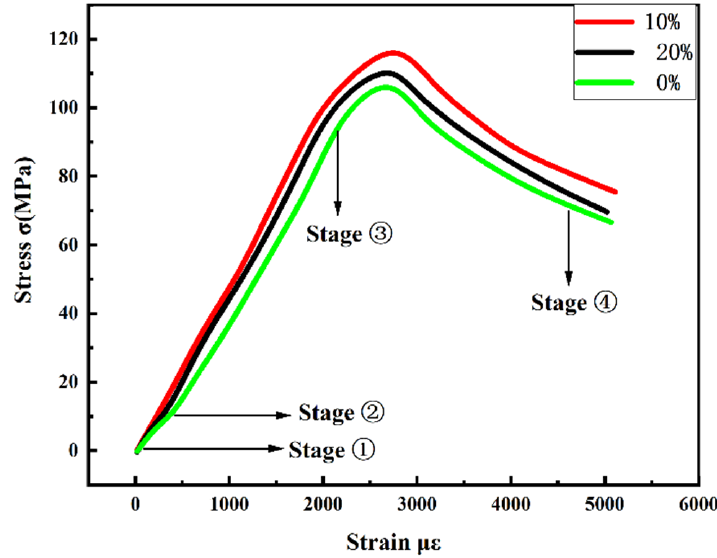
Figure 13. Compressive stress–strain curve.